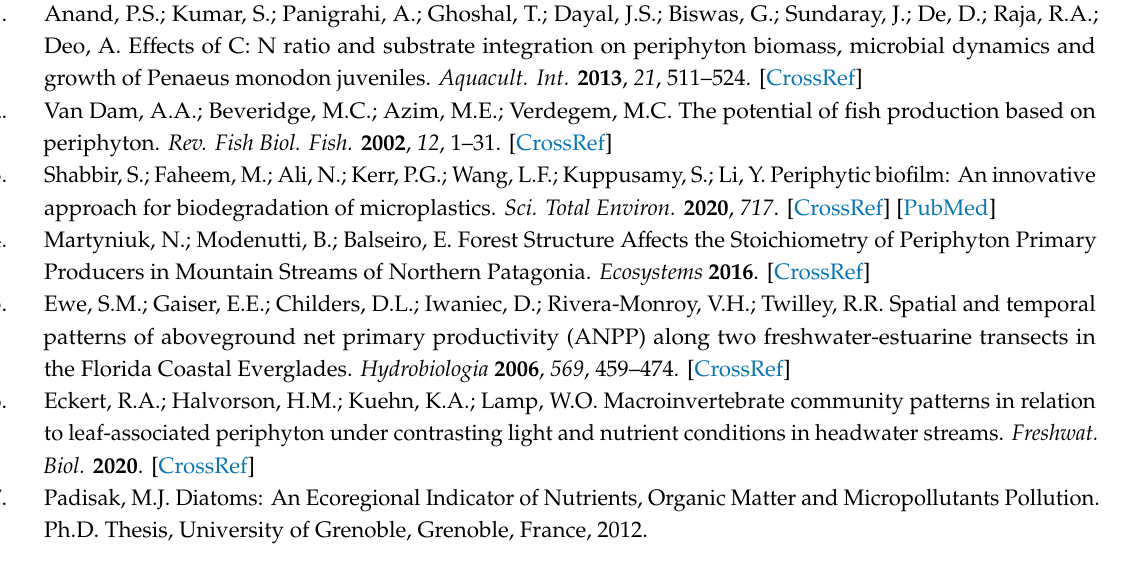
Table S1. Structure and properties of polyethylene microplastic; Table S2. Experimental design for epiphyton containing metals, methane and polyethylene; Table S3. Experimental design for epixylon containing metals, methane and polyethylene; Table S4. Primers and PCR amplification conditions used in this study; Table S5. Molecular weight changes of polyethylene determined by GPC; Figure S1. Scanning Electron Microscopy at 10 µ m of epiphyton and epixylon (a) SEM micrograph of epiphyton before treatment with 120000 ppm 13 CH4 (b) SEM micrograph of epiphyton after treatment with 120000 ppm 13 CH4 (c) AWCD and diversity indices of epiphyton (d) SEM micrograph of epixylon before treatment with 120000 ppm 13CH4 (e) SEM micrograph of epixylon after treatment with 120000 ppm 13 CH4 (f) AWCD and diversity indices of epixylon. Thread like structures are algae and dead bacterial aggregates are clearly visible in after treatments; Figure S2. Percentage of 13 C atoms abundance accumulated by methanotrophs under di ff erent methane, heavy metals doses along with polyethylene treatments (a) Epixylon 13 C atom (%) assimilation (b) Epiphyton 13 C atom (%)